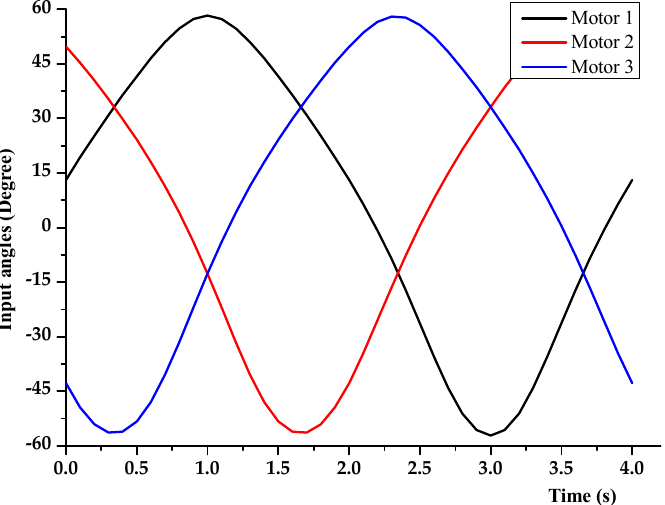
Figure 19. Motor output angle diagram, total stroke angle was about 117°.